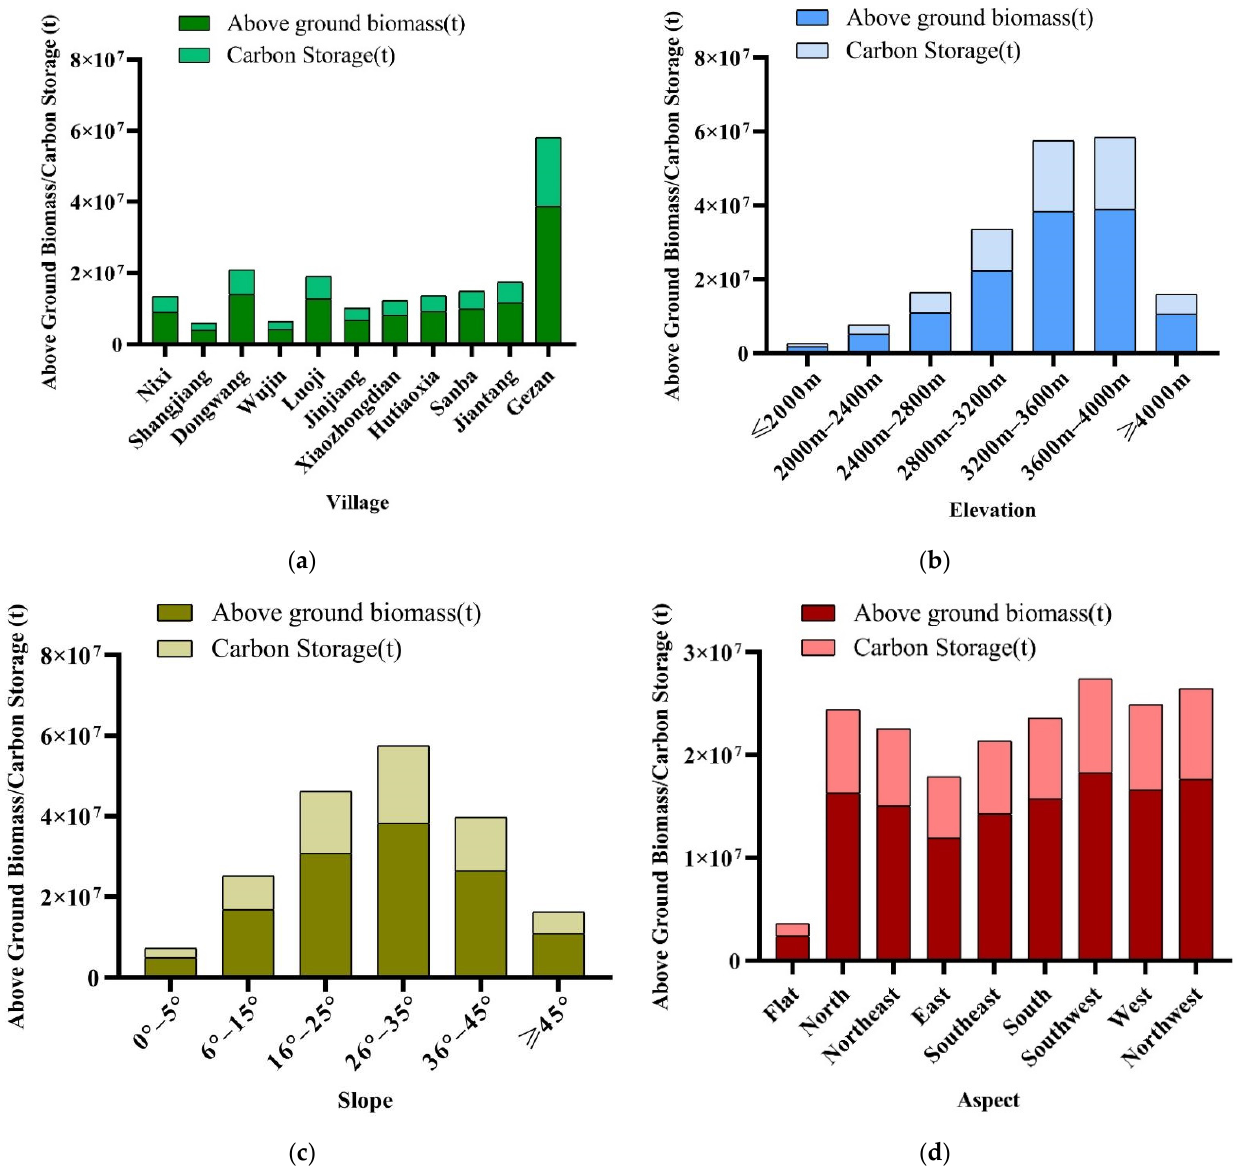
Figure 12. Spatial distribution of the aboveground biomass and carbon storage in Shangri-La City: ( a ) Distribution in different townships; ( b ) Distribution at different elevations; ( c ) Distribution at different slopes; ( d ) Distribution in different slope directions.